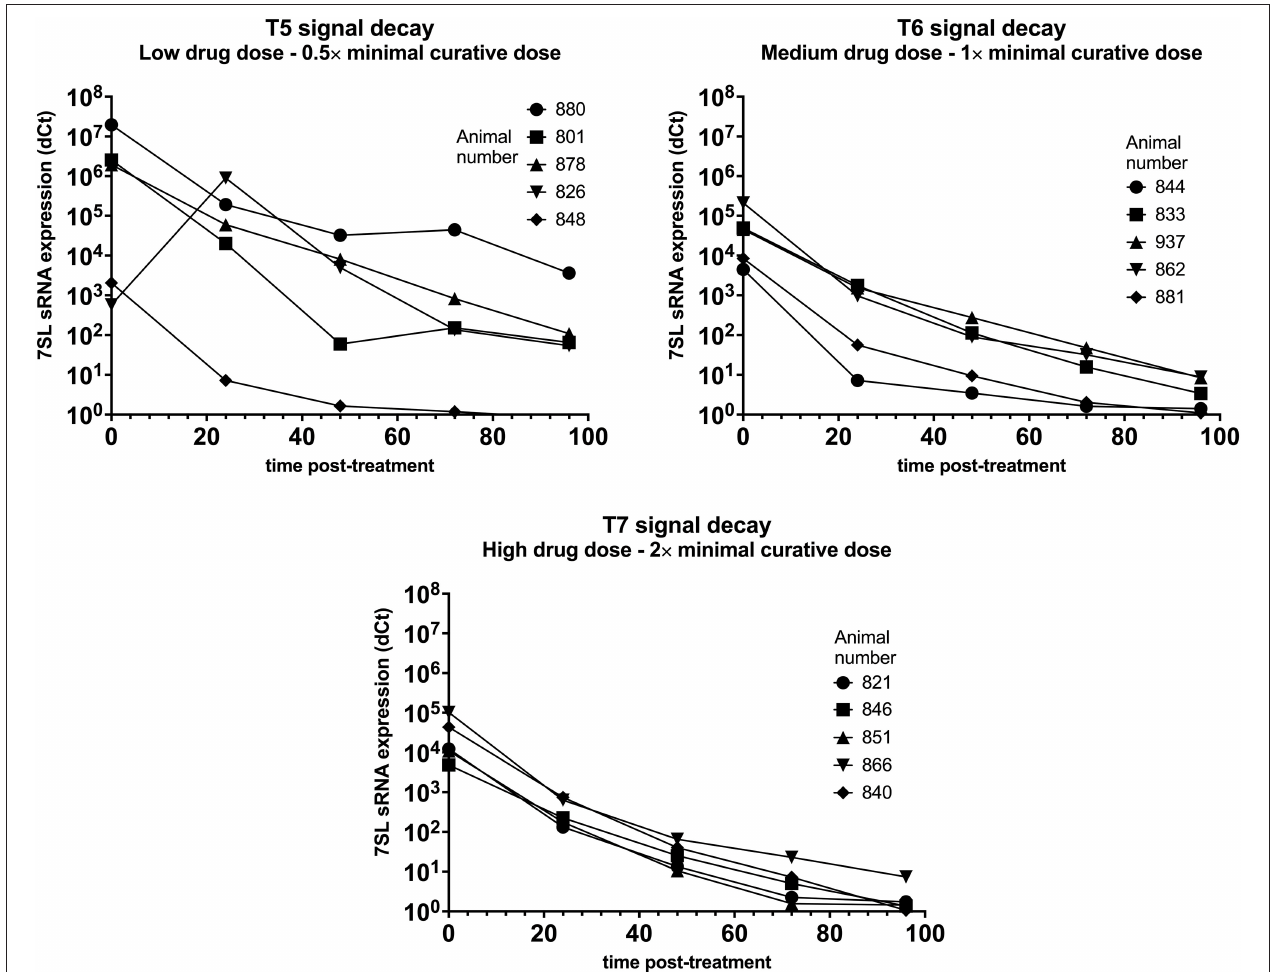
FIGURE 4 | Decay of 7SL sRNA signal in T. vivax infected cattle after trypanocide treatment. Cattle (Holstein-Friesian, n = 5 per treatment group) were infected with T. vivax STIB 719 (day 0) at peak parasitaemia (1 × 10 4 -5 × 10 5 trypanosomes/ml), cattle were treated with a low (equivalent to 0.5 × minimal effective dose), medium (1 × ) or high dose (2 × ) of an experimental trypanocide. Relative expression of 7SL sRNA by RT-qPCR is shown with a black line and was calculated by normalizing to an uninfected